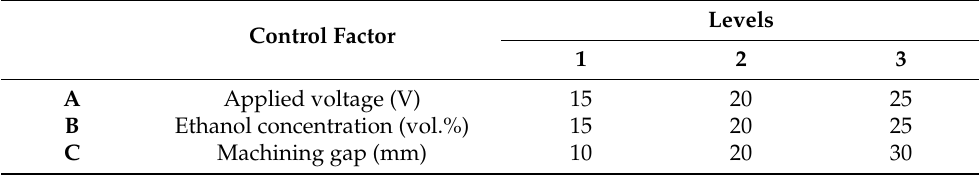
Table 5. Factors and levels of the EP machining